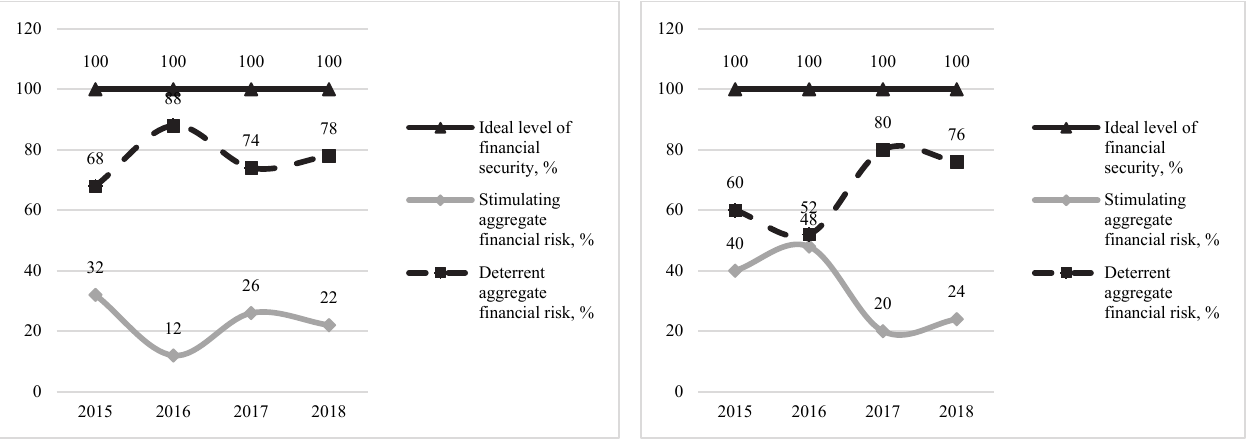
Fig. 10. Impact of restraining financial risk on the level of financial security of PJSC “Kharkiv Tractor Plant” in 2015- 2018, %*